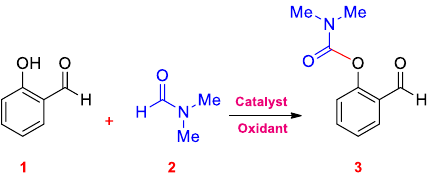
Table 1. Optimization of the reaction conditions of synthesis of carbamates a